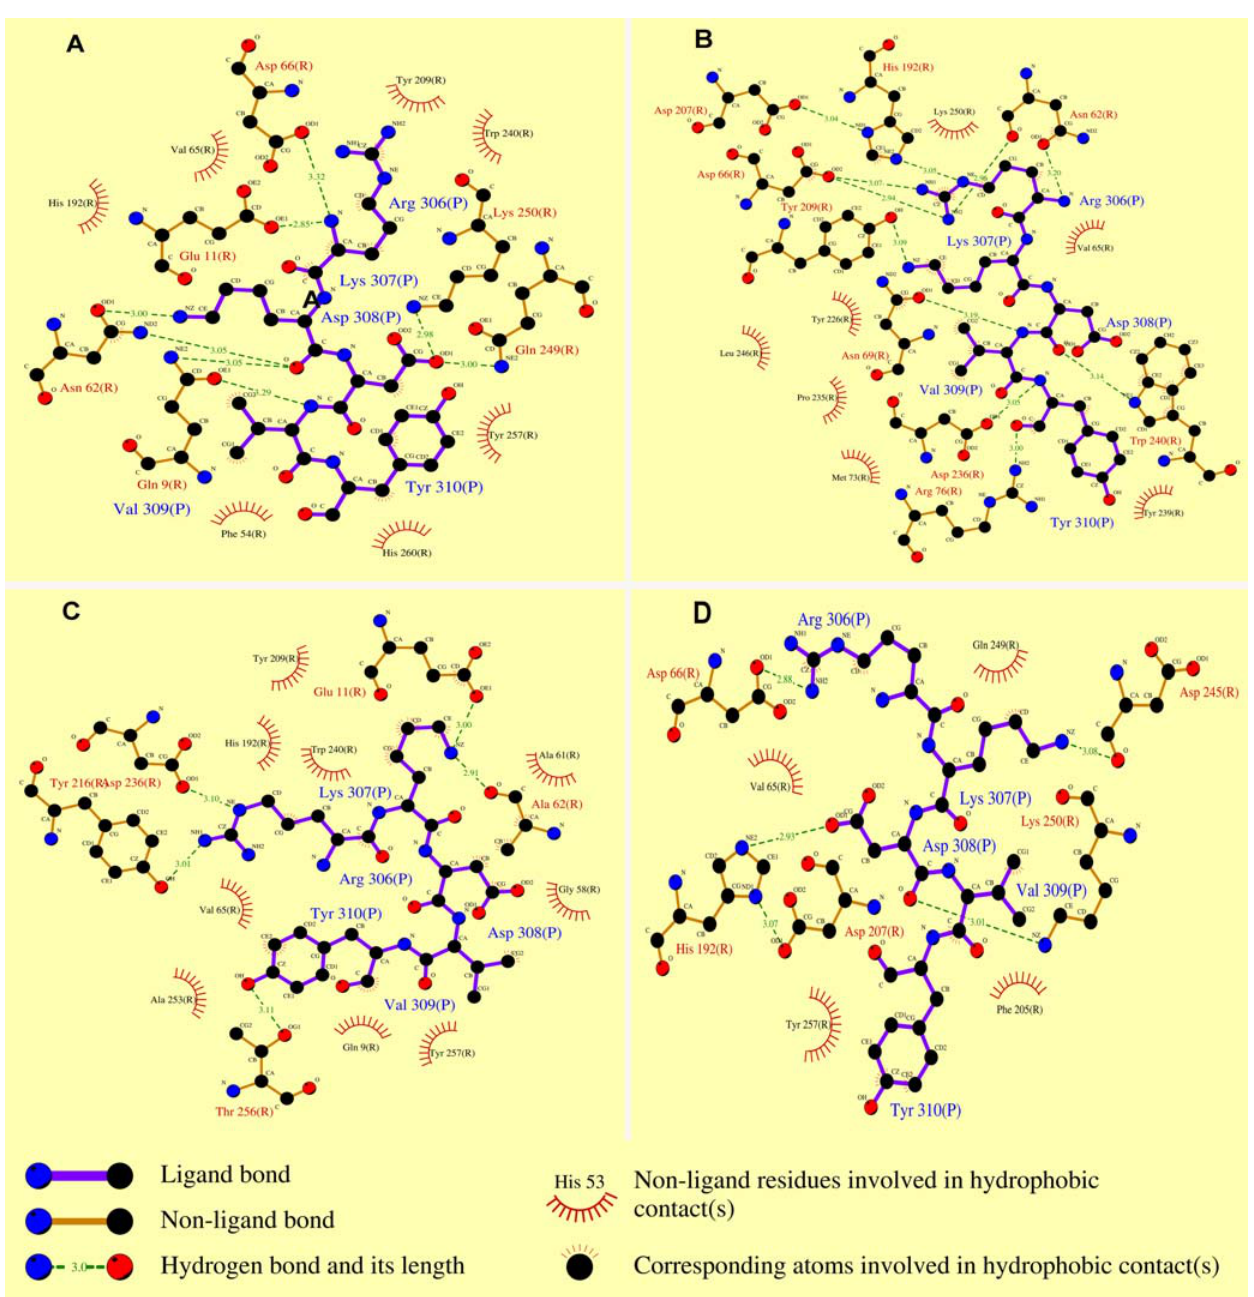
Figure 7. The 2D schemes of the predicted binding of TP5 to HLA-DR and its mutants. The schemes of TP5 binding HLA-DR (A), DR11 (B), DR62 (C), and DR11/62 (D) were resulted from the Ligplot program [42].